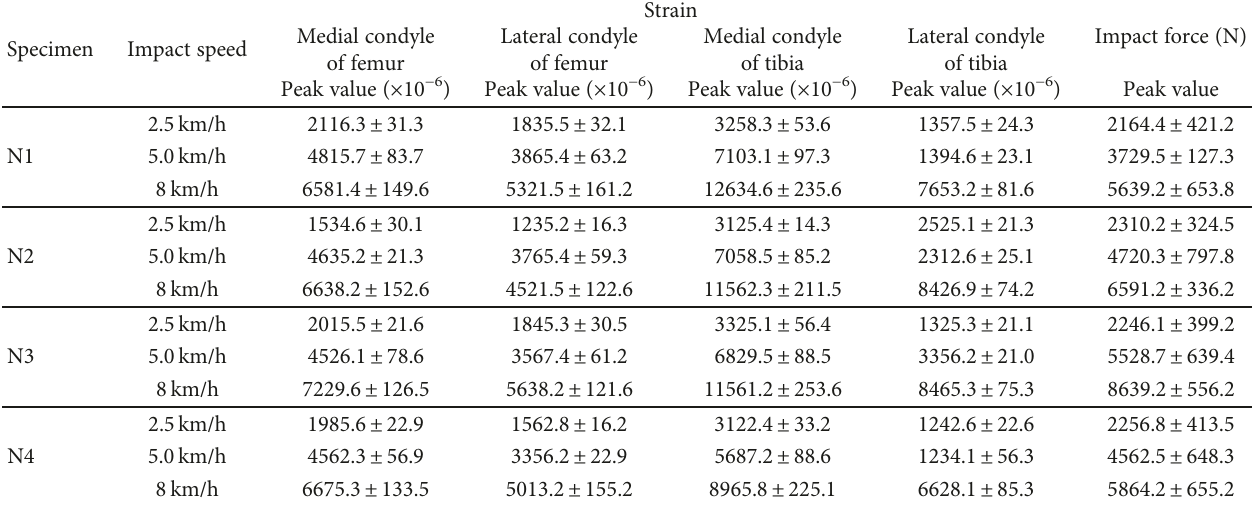
Table 3: Strain and impact force of knee